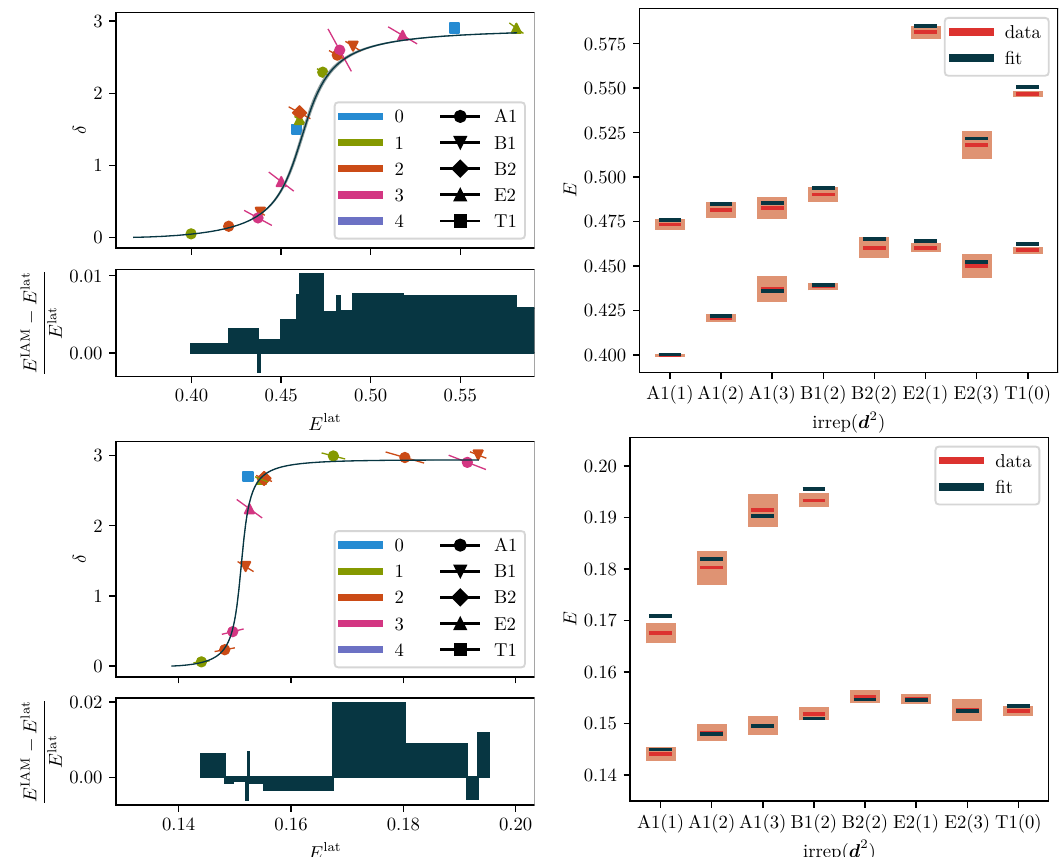
Figure 1. The fit IAM in comparison to the 2 π lattice data. The top (bottom) plots correspond to the lattice data of ref. [8] (ref. [136]). On the left-hand side, the phase is depicted. Here the markers encode the irreducible representations (irreps) of the residual rotational symmetry on the lattice, while the colors encode the square of the boost momentum d = L P with L 3 the spatial volume of 2 π the lattice. On the right-hand side, the comparison is shown on the energy level, with the statistical uncertainty of the lattice data indicated by the light red boxes. All energies are given in lattice